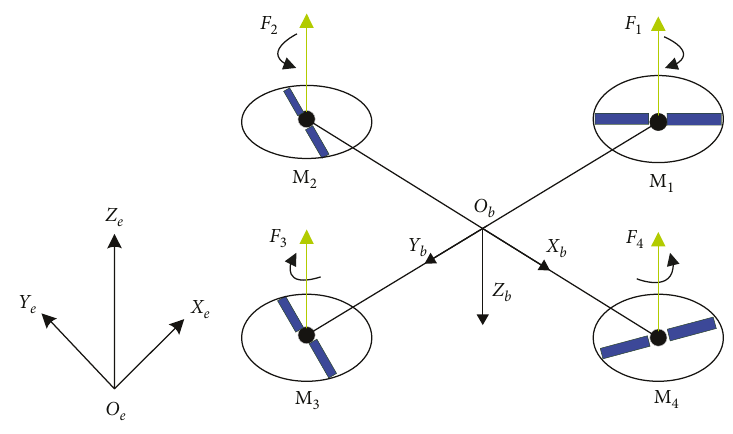
Figure 1: The quadrotor UAV with four